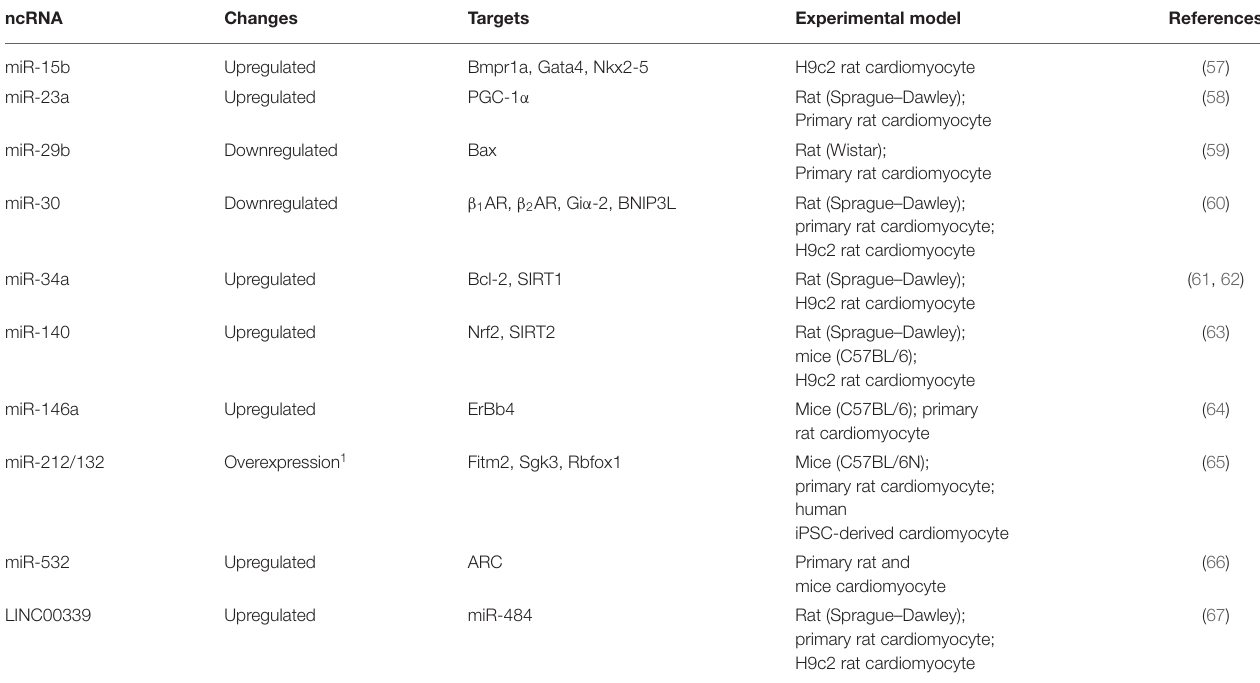
TABLE 2 | Expression changes of ncRNA in cardiomyocytes treated with